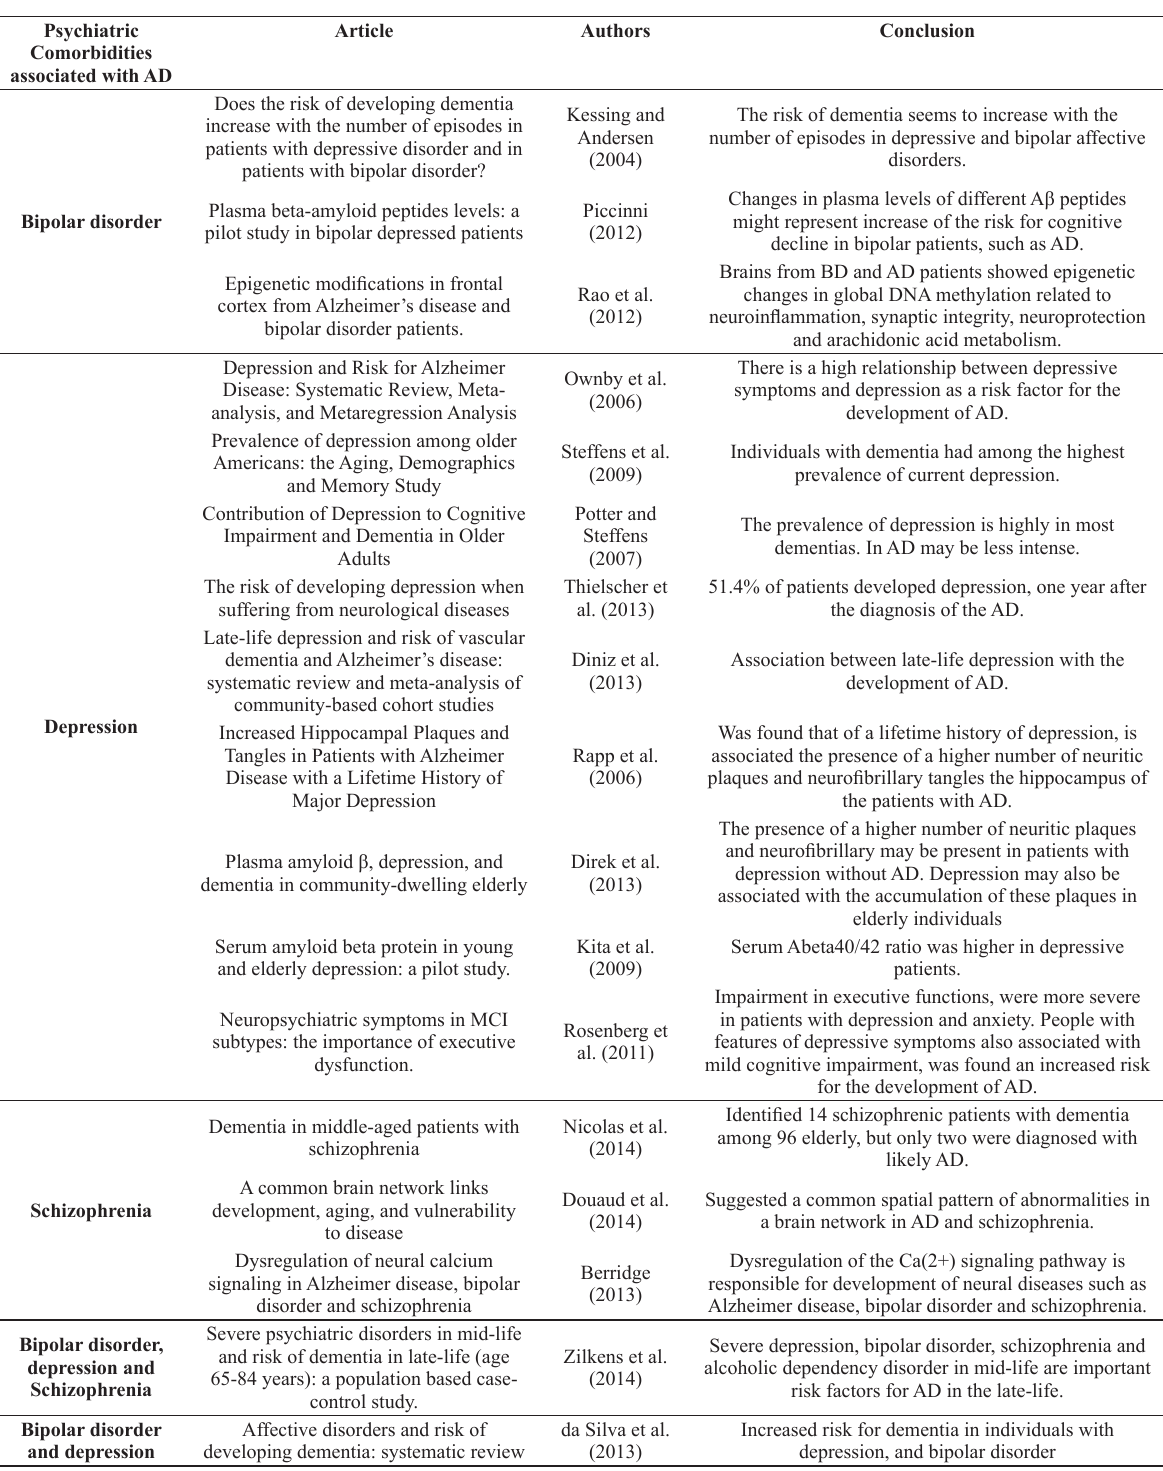
Associations between AD and bipolar disorder, depression and